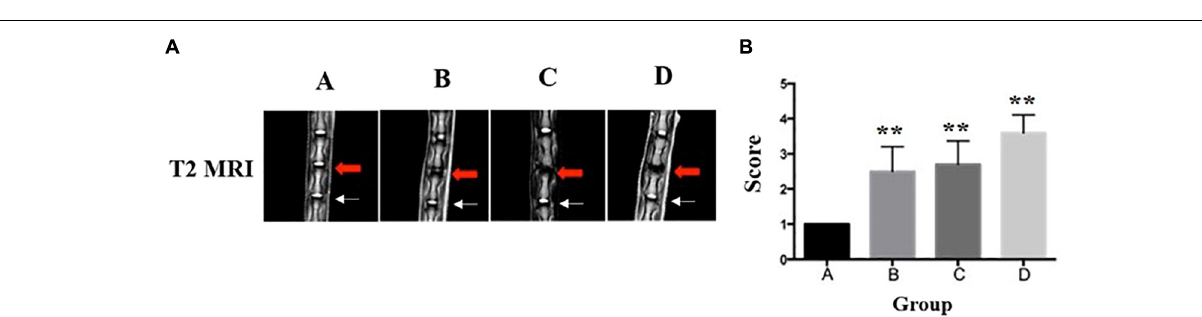
FIGURE 4 | Representative T2-weighted MRI of the lumbar spine of rats in group A, group B, group C, and group D (red arrow: injured Co7/8, white arrow: uninjured Co8/9). (A) The disk of Co7/8 (red arrow) showed a moderate decrease of signal intensity in group B and a severe decrease of signal intensity in group C. The signal intensity in group D demonstrated whole-disk degeneration. In all groups, no degeneration was observed in the adjacent disks (white arrow). (B) The Pfirrmann MRI grade scores in three experimental groups (group B and group C and Group D) compared to the control group (five rats at each time point for each group). **Significant difference from other group disks ( p ≤